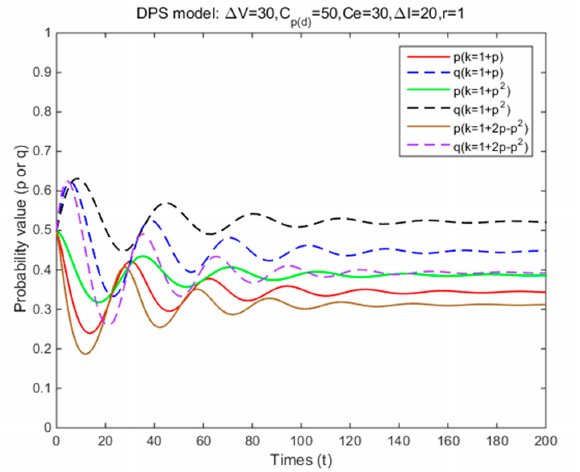
Figure 4. The effects of dynamic penalty coefficient on strategy probabilities of cyclists and law enforcement under DPS (Situation 3).